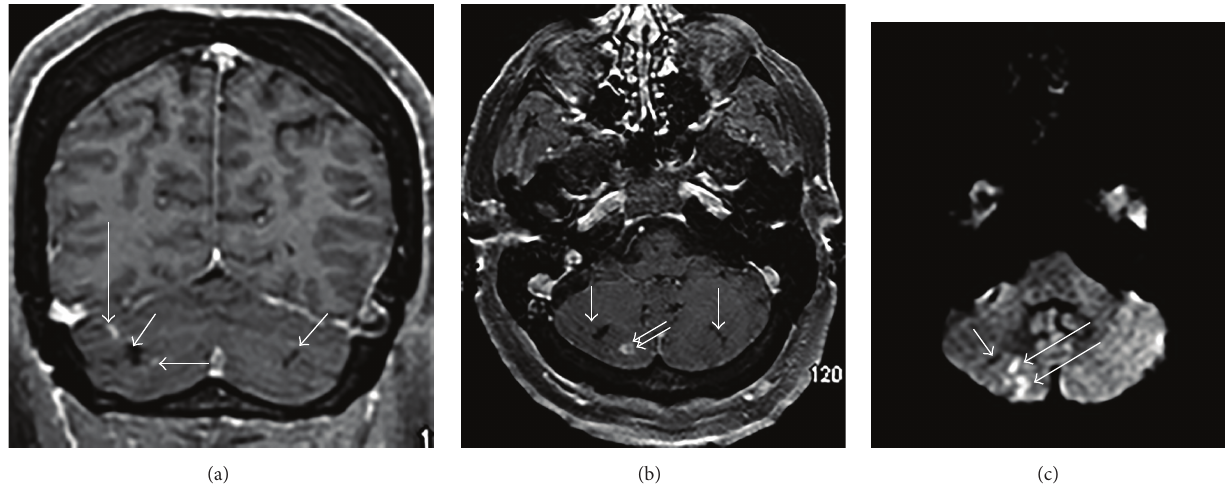
Figure 1: (a) Coronal postcontrast T1 weighted magnetic resonance (MR) image shows areas of old (chronic) infarction in the equators of both cerebellar hemispheres (short white arrows) and small, enhancing subacute infarcts in right cerebellum (long white arrows). (b) Axial postcontrast T1 weighted MR image shows areas of old (chronic) infarction in both cerebellar hemispheres (single white arrows) and an enhancing subacute infarct in the right cerebellum (double white arrow). (c) Axial diffusion weighted MR image (DWI) through the posterior fossa shows a small, old right cerebellar infarct (short white arrow) and areas of subacute infarction with diffusion restriction (long white